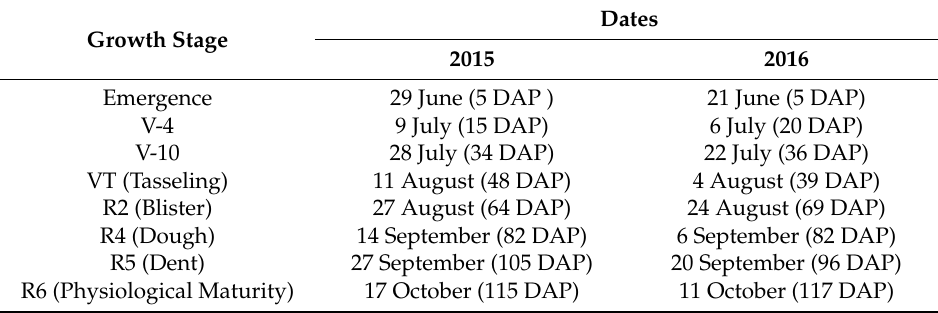
Table 2. Specific growth stages and dates for corn grown during the 2015 and 2016 growing season in Bushland, TX,